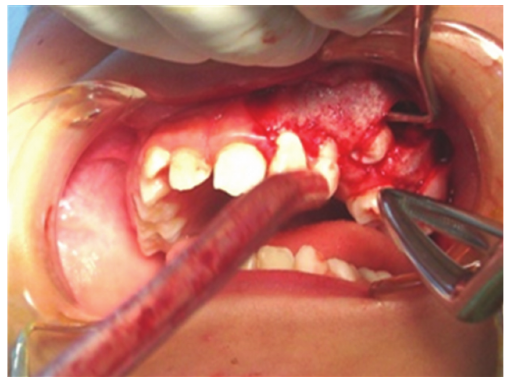
Figure 7: Premolar tooth in cyst.